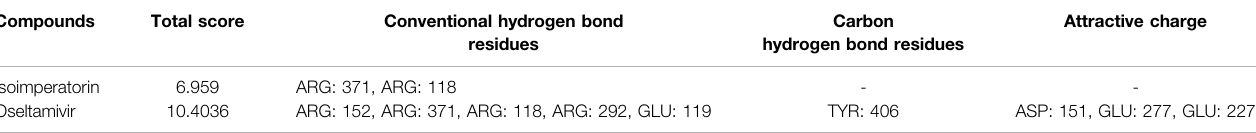
TABLE 4 | The total scores and residues for the chemical bonds between compounds and neuraminidase. Compounds Total score Conventional hydrogen bond